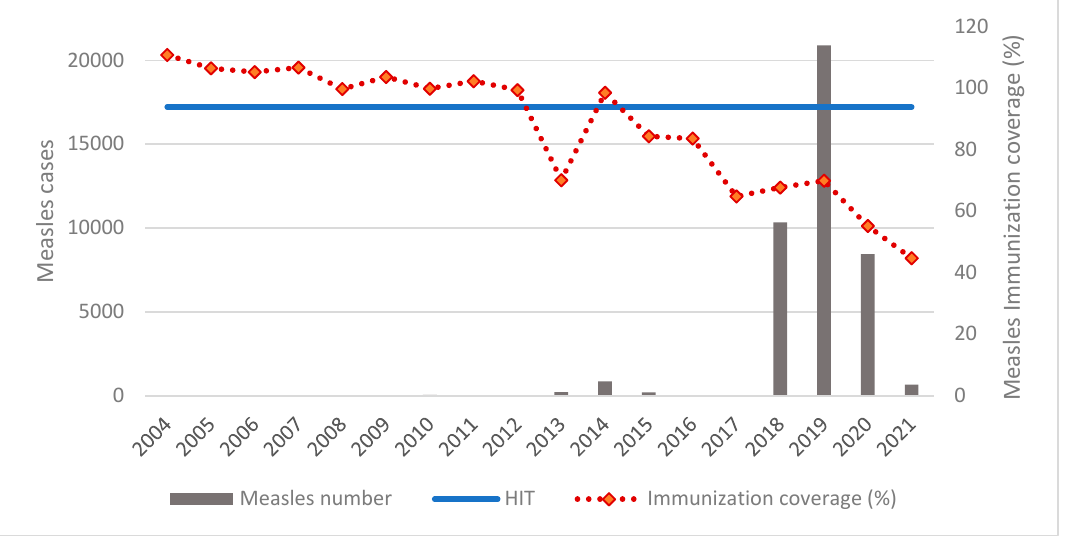
Figure 3. Relationship between measles case numbers and immunization coverage in Brazil, 2004–2021 [7,9]. HIT: herd immunity threshold.